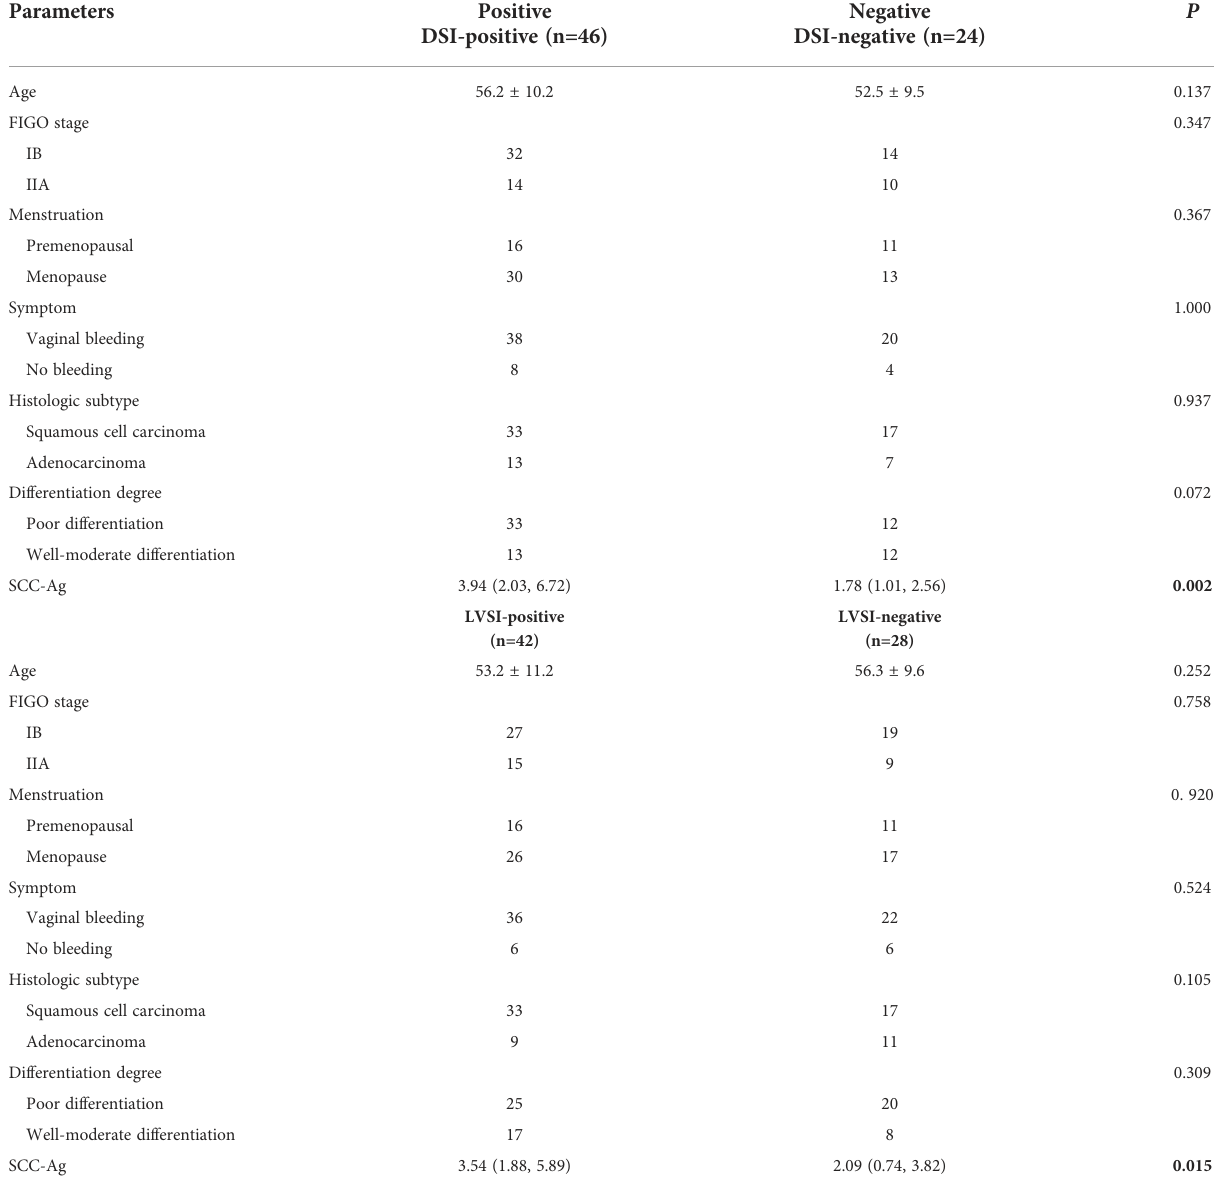
TABLE 1 Comparison of clinical characteristics and pathological features between DSI and LVSI positive and negative groups.